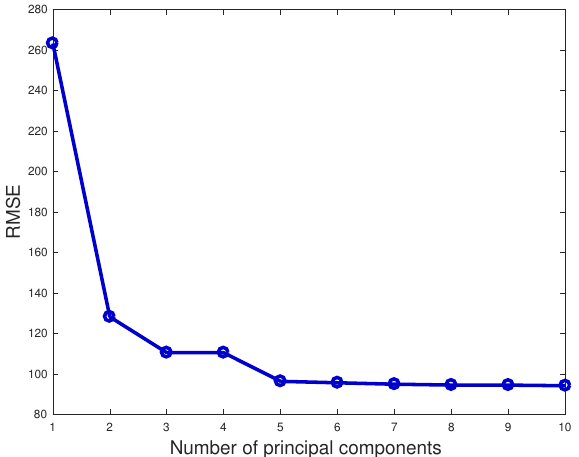
Figure 8. Average RMSE as a function of the number of principal components included in the